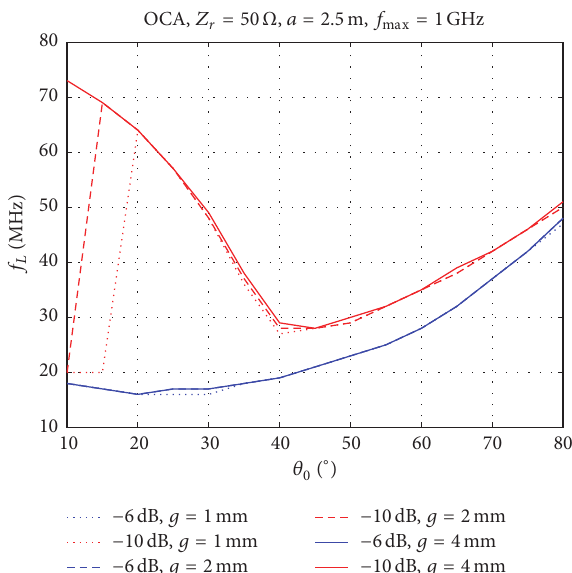
Figure 27: 𝑓 𝐿 × 𝜃 0 chart for the OCA for 3 different gap lengths and Ω . 𝑍 𝑟 = 50